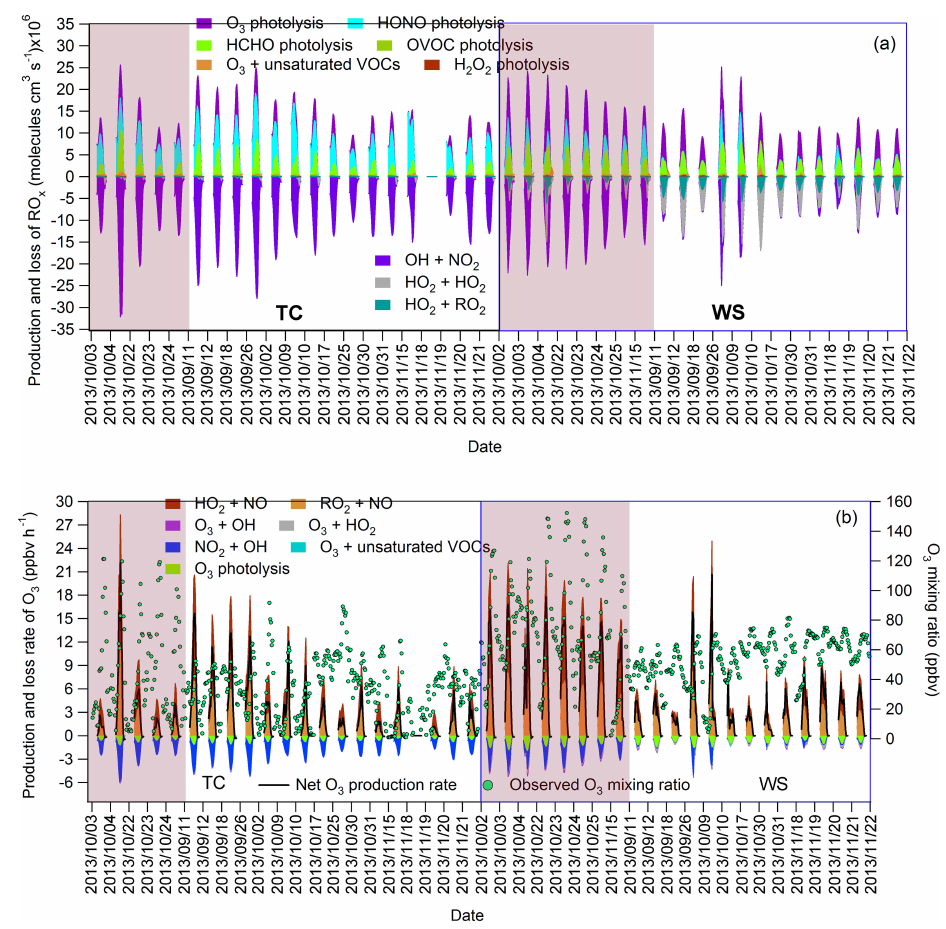
Figure 5. Daytime (07:00–19:00LT) variations of the simulated production and loss rates of (a) RO x and (b) O 3 at TC (left panel) and WS (right panel). O 3 episode days are highlighted in red background. The dates are not consecutive due to the discontinuous canister sampling of